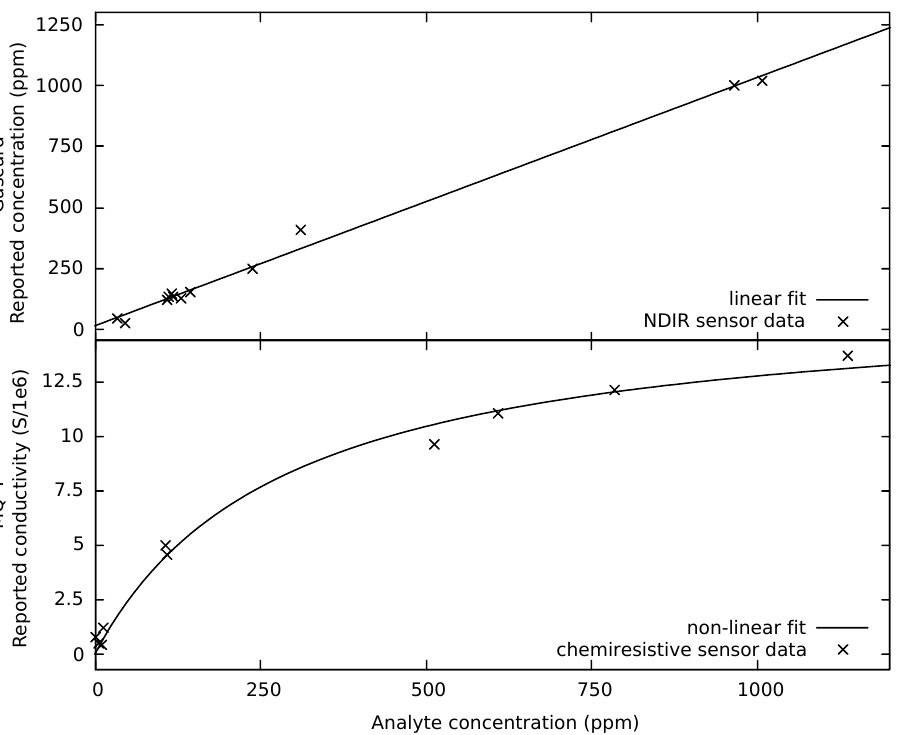
Figure 4. The upper panel of the figure shows the reported concentration from a Gascard optical CO 2 sensor along with the expected linear fit. The lower panel of the figure shows reported conductivity measured from an MQ-4 chemiresistive CH sensor along with a fit to the expected non-linear fit. 4 The analyte gas at various concentrations was generated by the gas mixing apparatus (Figure 1) and measured using California Analytical Instruments Inc. ZRE Non-Dispersive Infrared